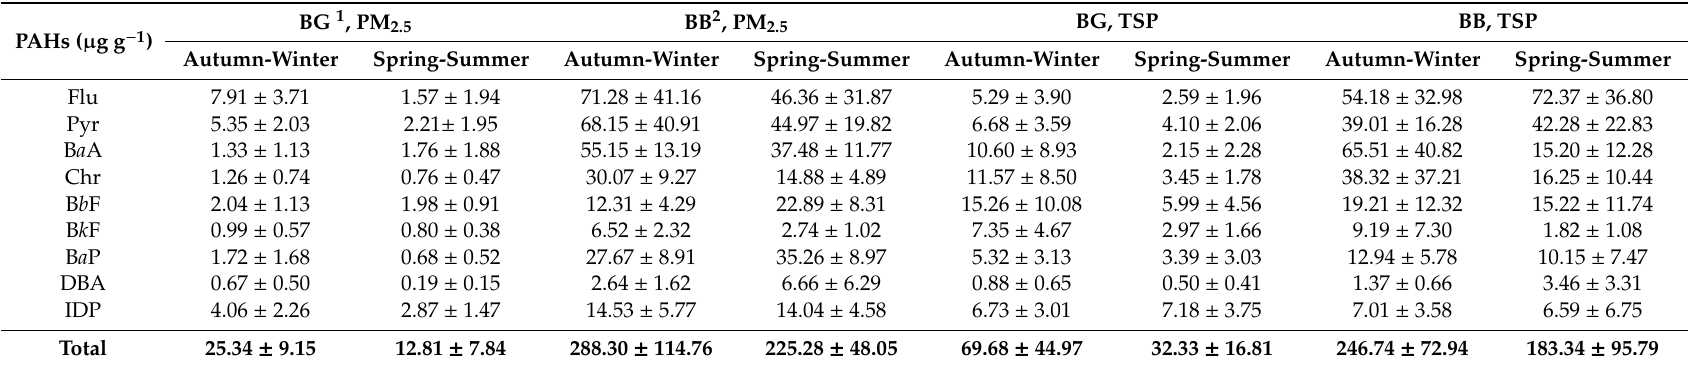
Table 2. PAHs content in PM ( µ g / g